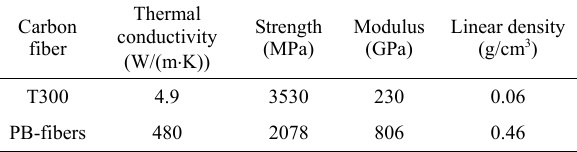
Table 1 Properties of T300 and PB-fibers [15]